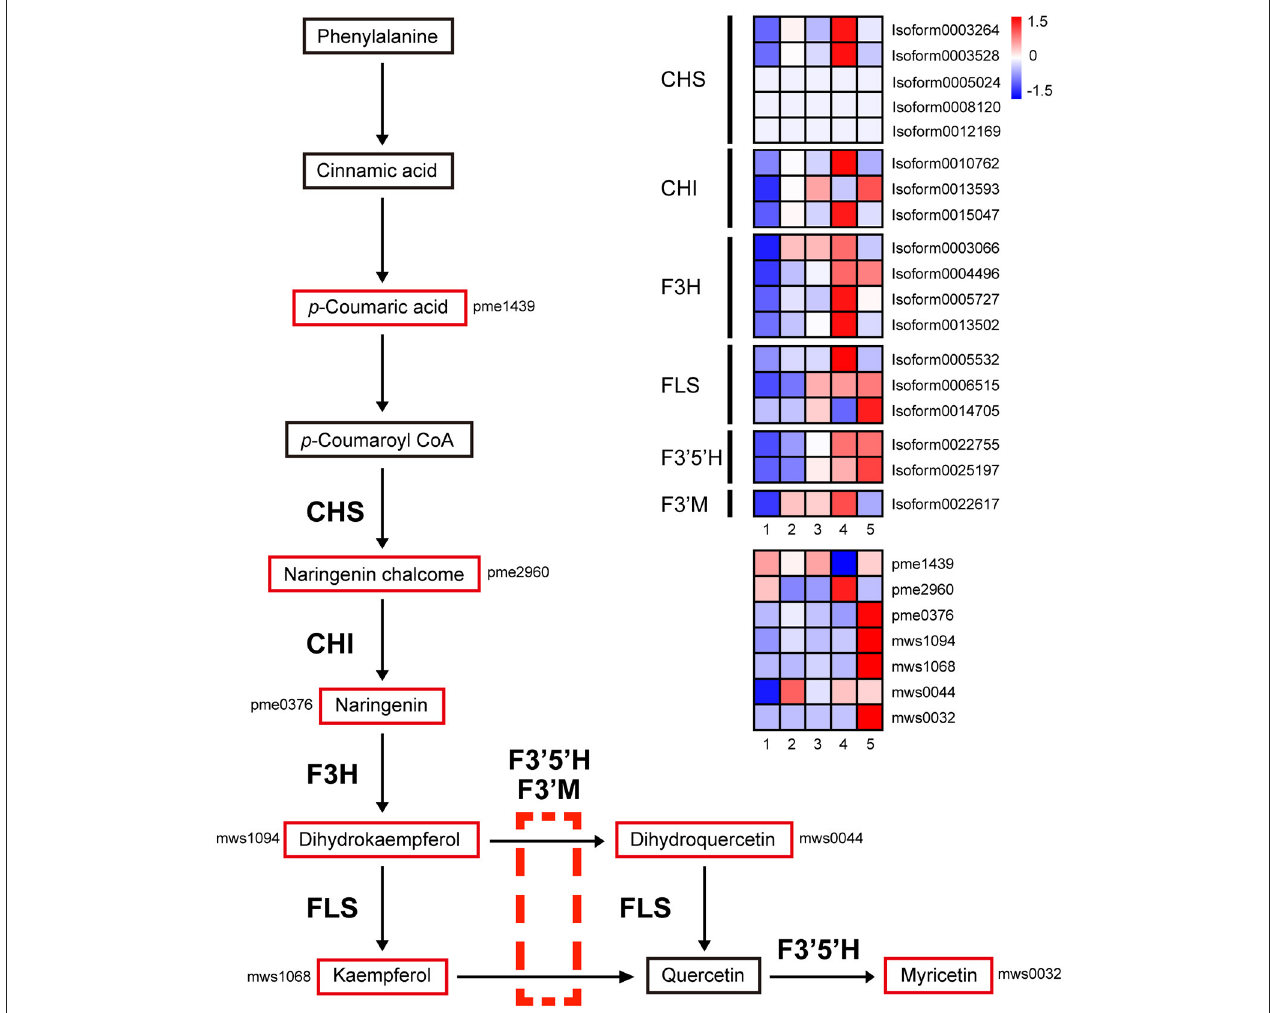
FIGURE 8 | Transcript and metabolic profiling of genes in the flavonoid and flavonol biosynthetic pathways in M. pasquieri . The heatmap is drawn according to the average expression levels of related biosynthetic genes and relative accumulation levels of related metabolites. A color bar is presented at the top right, and the colors from blue to red indicate low to high expression and accumulation. CHS, chalcone synthase; CHI, chalcone isomerase; F3H, naringenin 3-dioxygenase; FLS, flavonol synthase; F3 ′ 5 ′ H, flavonoid 3 ′ ,5 ′ -hydroxylase; F3 ′ M, flavonoid 3 ′